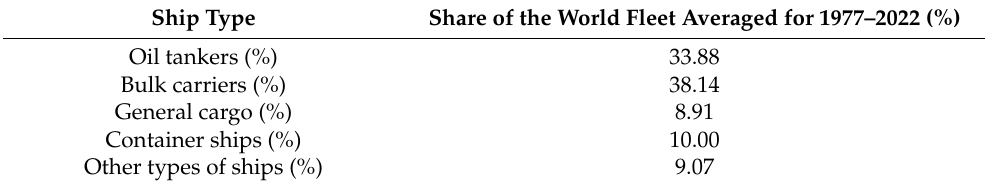
Table A1. Average share of ship types in the global fleet from 1977 to 2022 (UNCTAD, 2022).